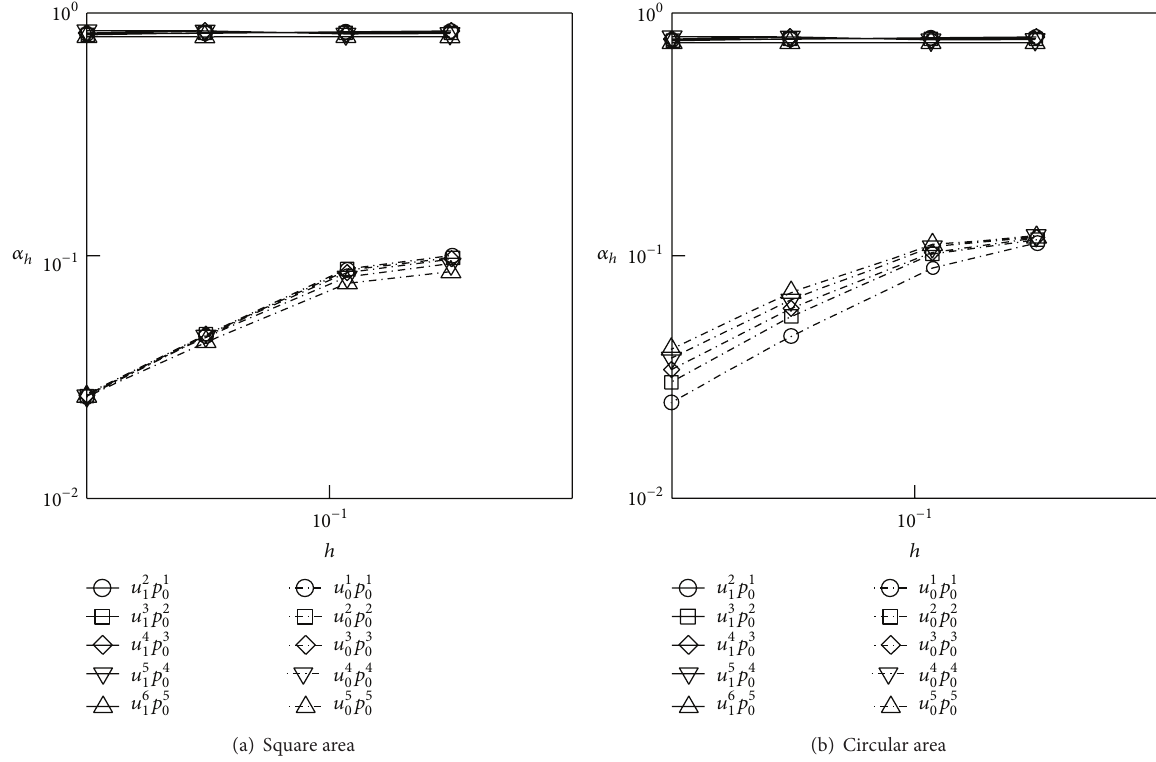
Figure 3: Inf-sup